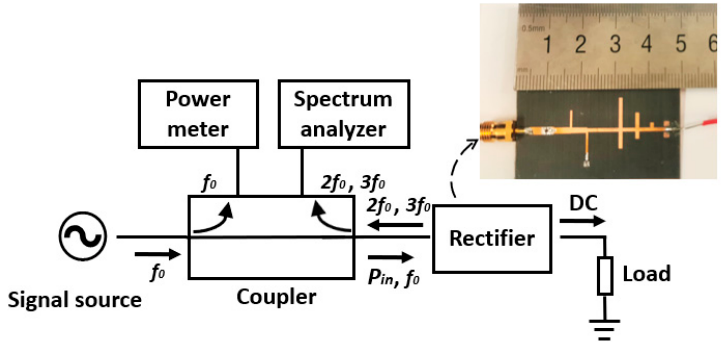
Figure 6. The schematic diagram of the rectifier efficiency measurement system.